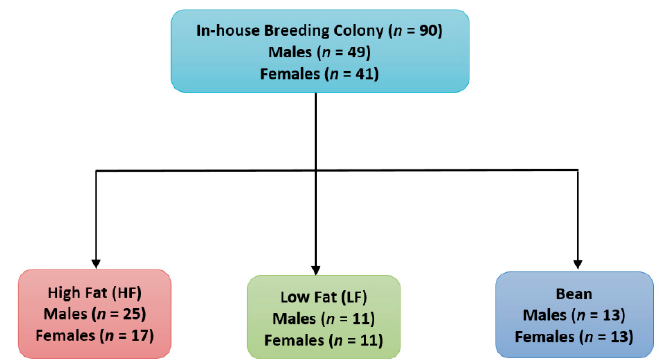
Figure 1. Experiment 1 flow chart.